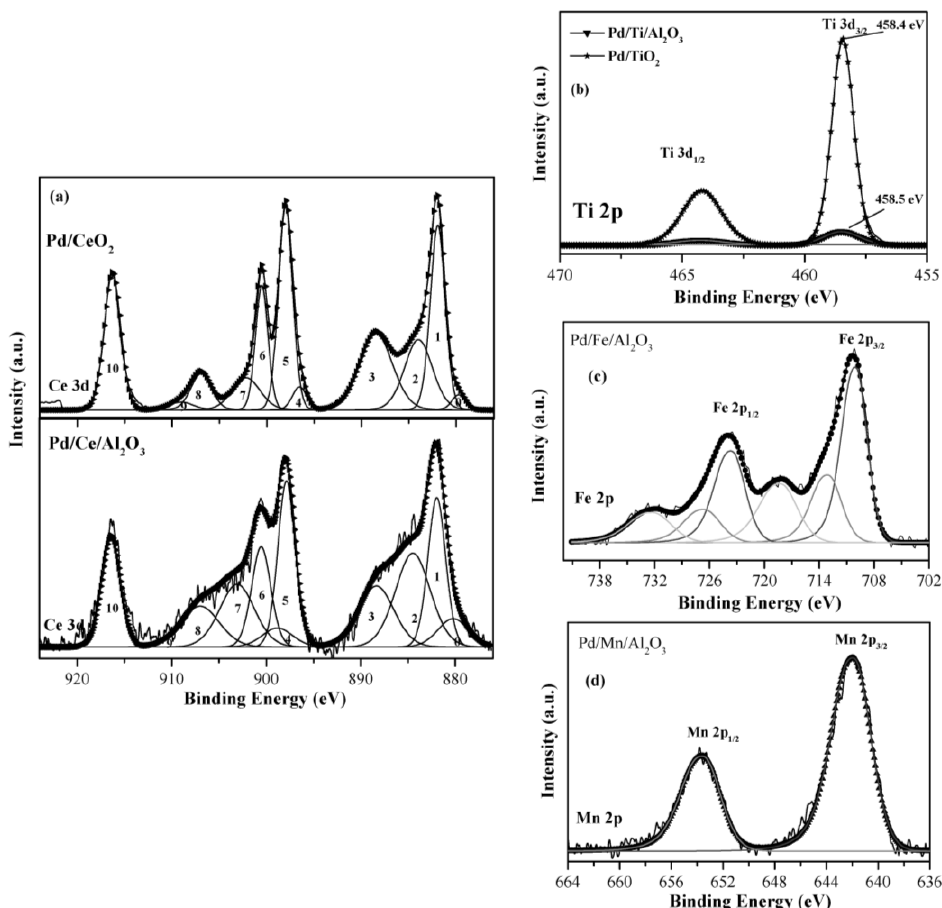
Figure 8. XPS spectra of Pd-supported catalysts: ( a ) Ti 2p; ( b ) Ce 3d; ( c ) Fe 2p; and ( d ) Mn